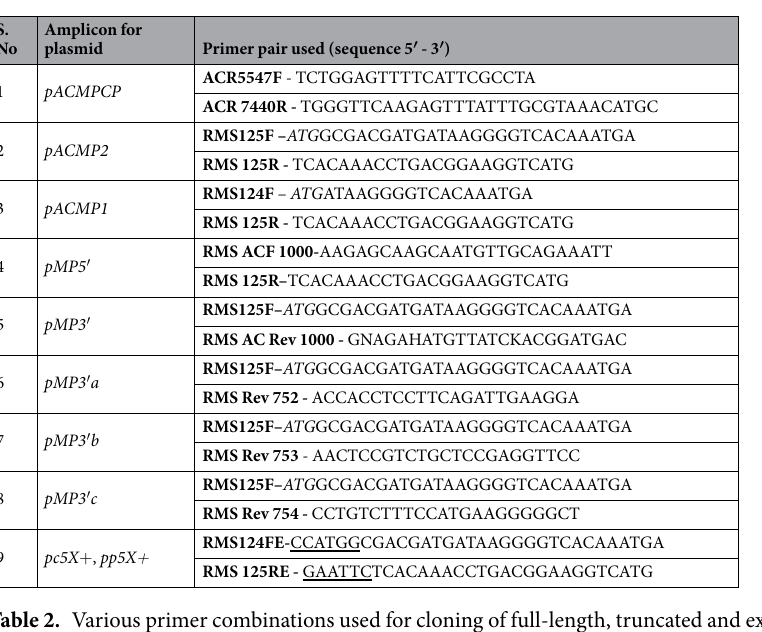
Table 2. Various primer combinations used for cloning of full-length, truncated and expression constructs of ACLSV MP . The initiation codons in plasmids pACMP1 and pACMP2 have been italicized. For preparation of constructs for pMAL vectors the enzyme sites in primers RMS 124FE and RMS 125RE have been underlined.